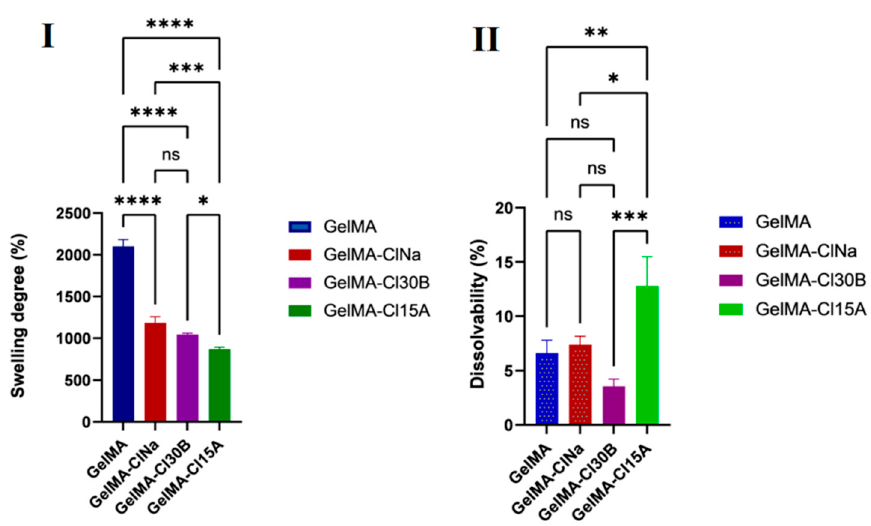
Figure 10. Swelling ( I ) and dissolvability ( II ) analyses of GelMA, GelMA-ClNa, GelMA-Cl30B, GelMA-Cl15A 3D printed scaffolds. ( I ) Statistical significance: ns p < 0.5; * p < 0.05; *** p < 0.0005; **** p < 0.0001; ( II ) statistical significance: ns p < 0.5; * p < 0.05; ** p < 0.005; *** p < 0.0005.